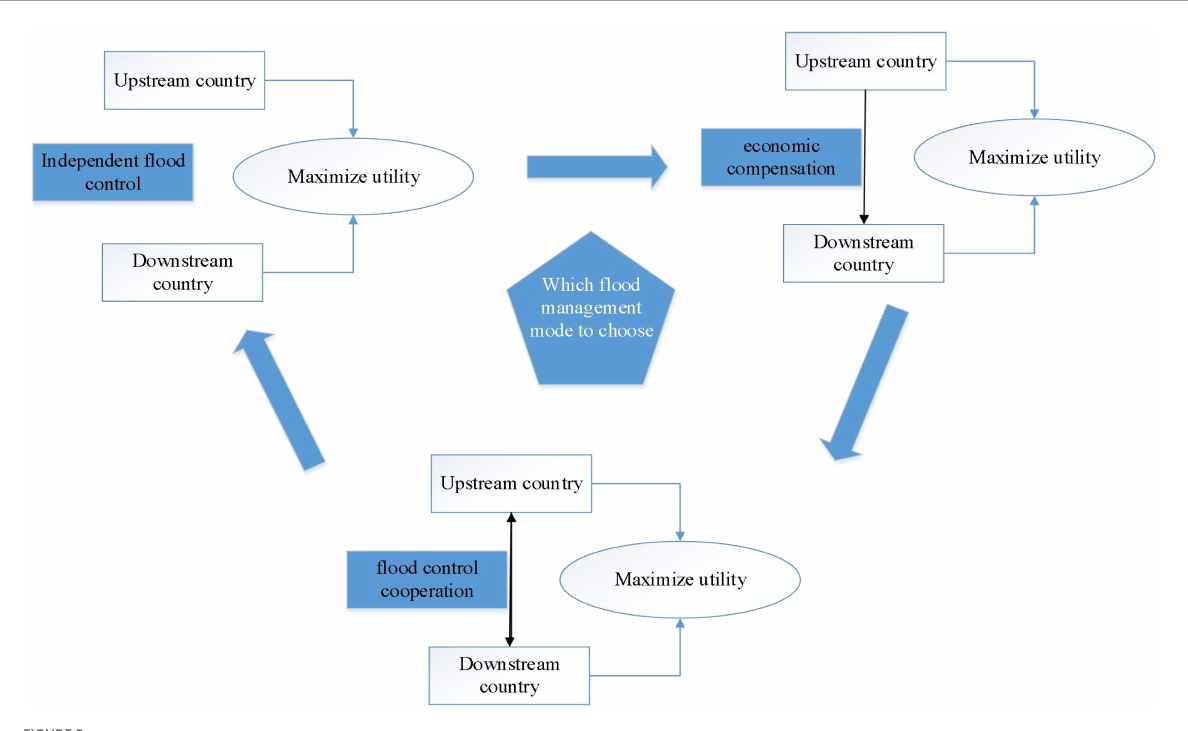
FIGURE2 Alternative flood management models for upstream and downstream countries.